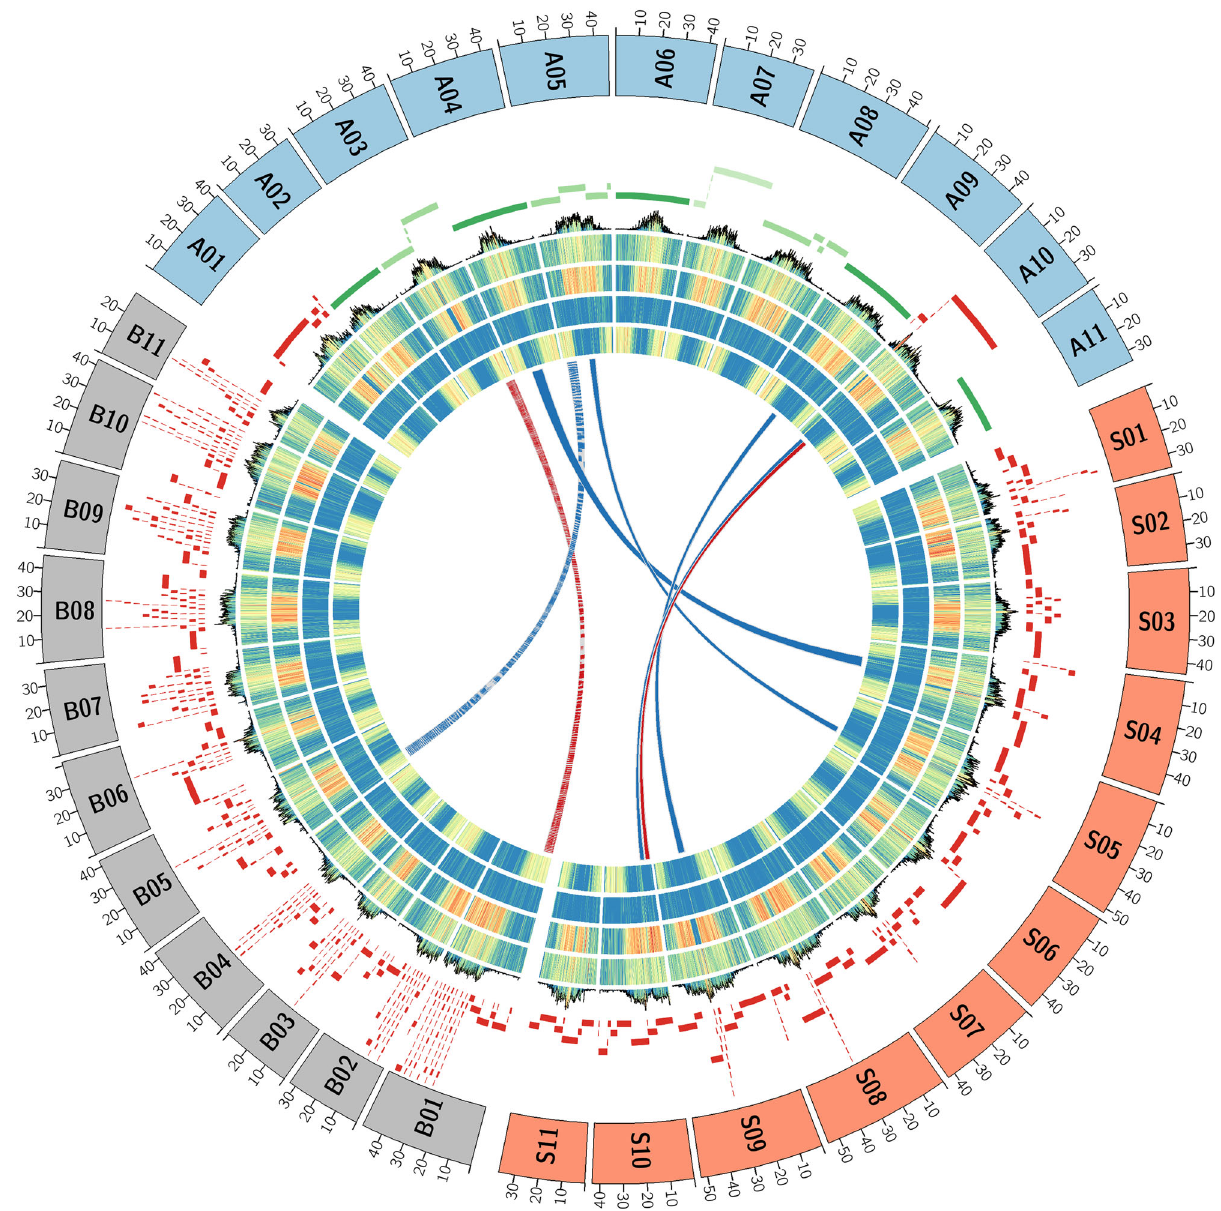
Fig. 1 Musa genomes architecture comparison. The tracks represent the following elements (from outer to inner): (1) schematic representation of M. acuminata (A), M. balbisiana (B) and M. schizocarpa (S) chromosome sequences, (2) contigs colored in green if the chromosome sequence is composed of 1 − 4 contigs, in red if the chromosome sequence is composed of more than 5 contigs. (3) Density of the centromeric repeats. (4) Density of the Gypsy elements. (5) Density of the Copia elements. (6) Density of the DNA transposons. (7) Density of genes. (8) Synteny relationships. The red lines show translocations between B01 and A03 and between S10 and A10. The blue lines show inversions between B05 and A05, S04 and A04, S05 and A05, S09 and